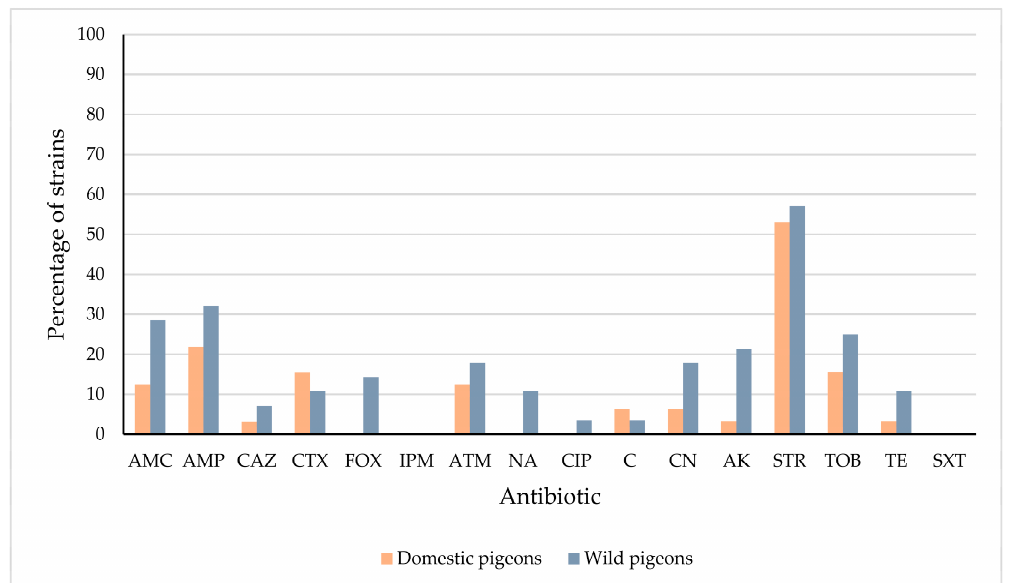
Figure 2. Percentage of Escherichia coli strains from domestic and wild pigeons with resistance or reduced susceptibility to each antibiotic tested. Amoxicillin-clavulanic acid (AMC); ampicillin (AMP); ceftazidime (CAZ); cefotaxime (CTX); cefoxitin (FOX); imipenem (IPM); aztreonam (ATM); nalidixic acid (NA); ciprofloxacin (CIP); chloramphenicol (C); gentamicin (CN); amikacin (AK); streptomycin (STR); tobramycin (TOB); tetracycline (TE); trimethoprim-sulfamethoxazole